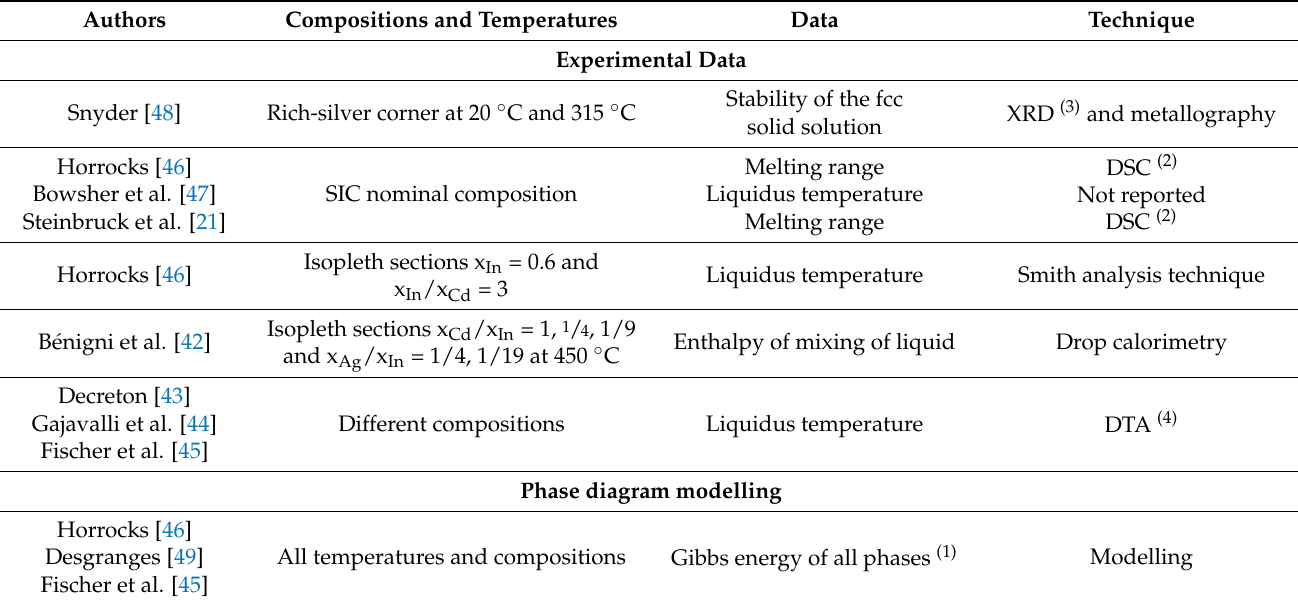
Table 1. Main thermodynamics information in the Ag-In-Cd ternary system.